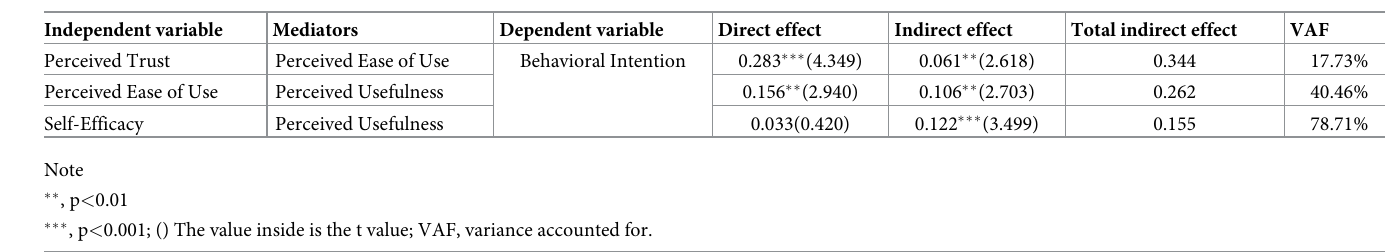
Table 4. Mediation effect